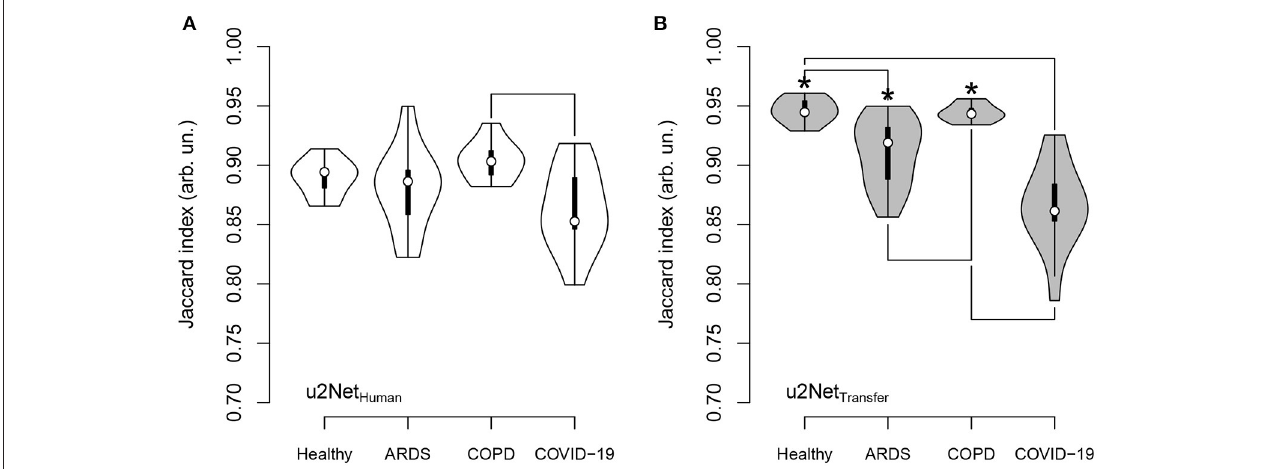
FIGURE 5 | Jaccard index for u 2 Net Human (A) and u 2 Net Transfer (B) and its dependence on clinical diagnosis; significance was tested using Kruskal-Wallis test followed by Nemenyi test; asterisk (*) indicates difference between networks; lines between diagnosis indicate difference between diagnosis; significance accepted at P < 0.05.